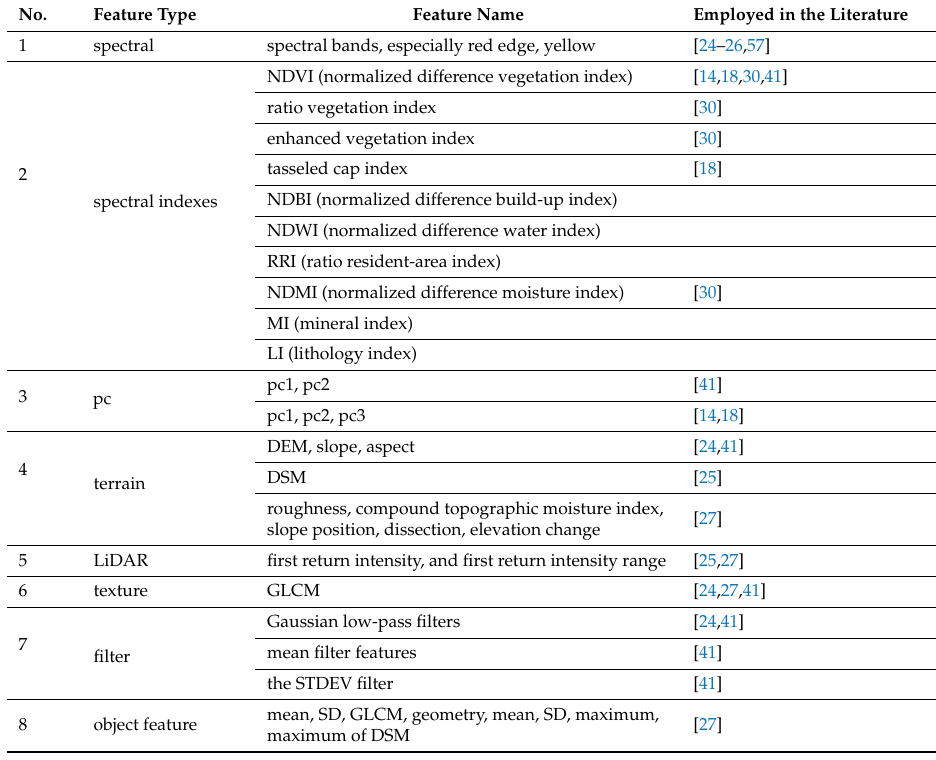
Table 3. Main features derived from the HR images and employed for LCCMA over the past two